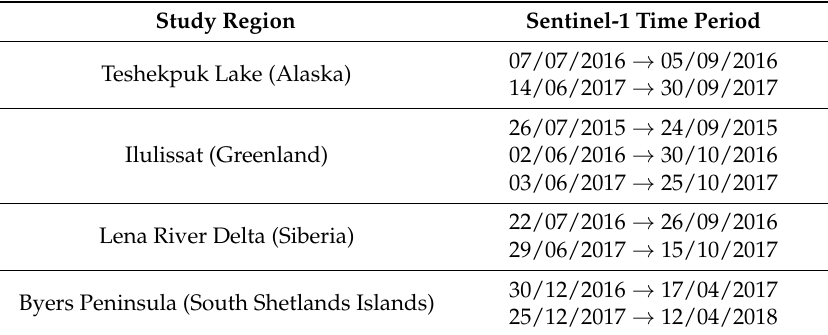
Table 1. Sentinel-1 time periods of observation for the different study